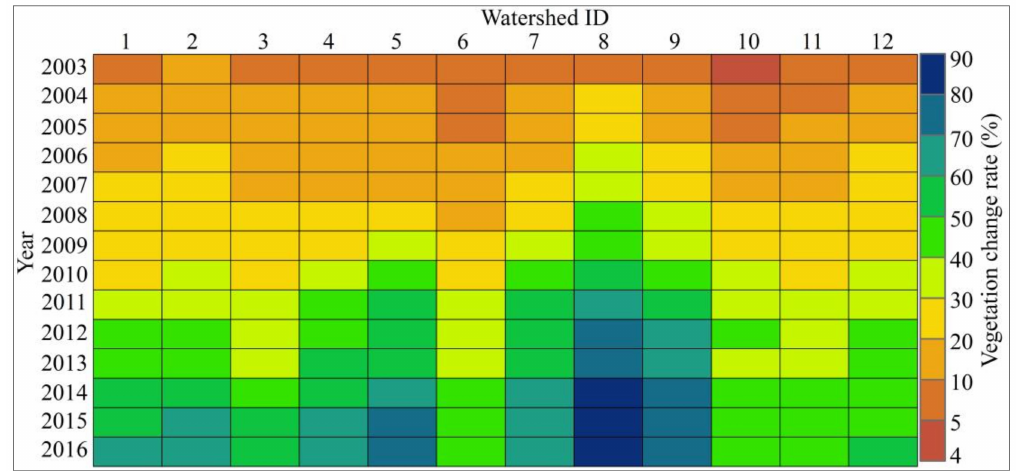
Figure 6. Percentage change of f PAR for the 12 watersheds during 2000–2018. All the change rates were compared with the base time period of